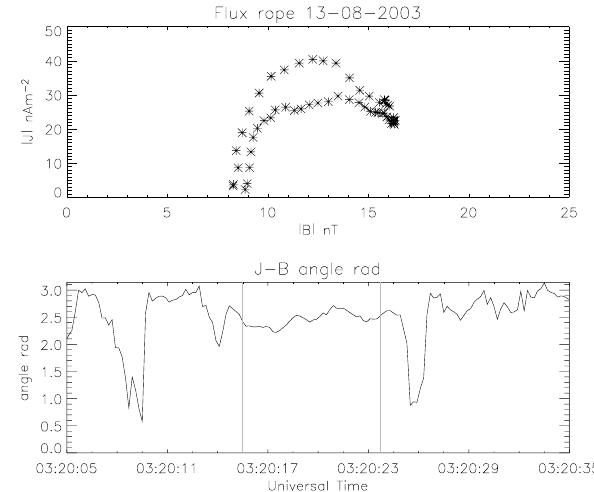
Fig. 15. | J | versus | B | and the angle (in radians) between the magnetic field and current density vectors for the 13 August 2003 flux rope.